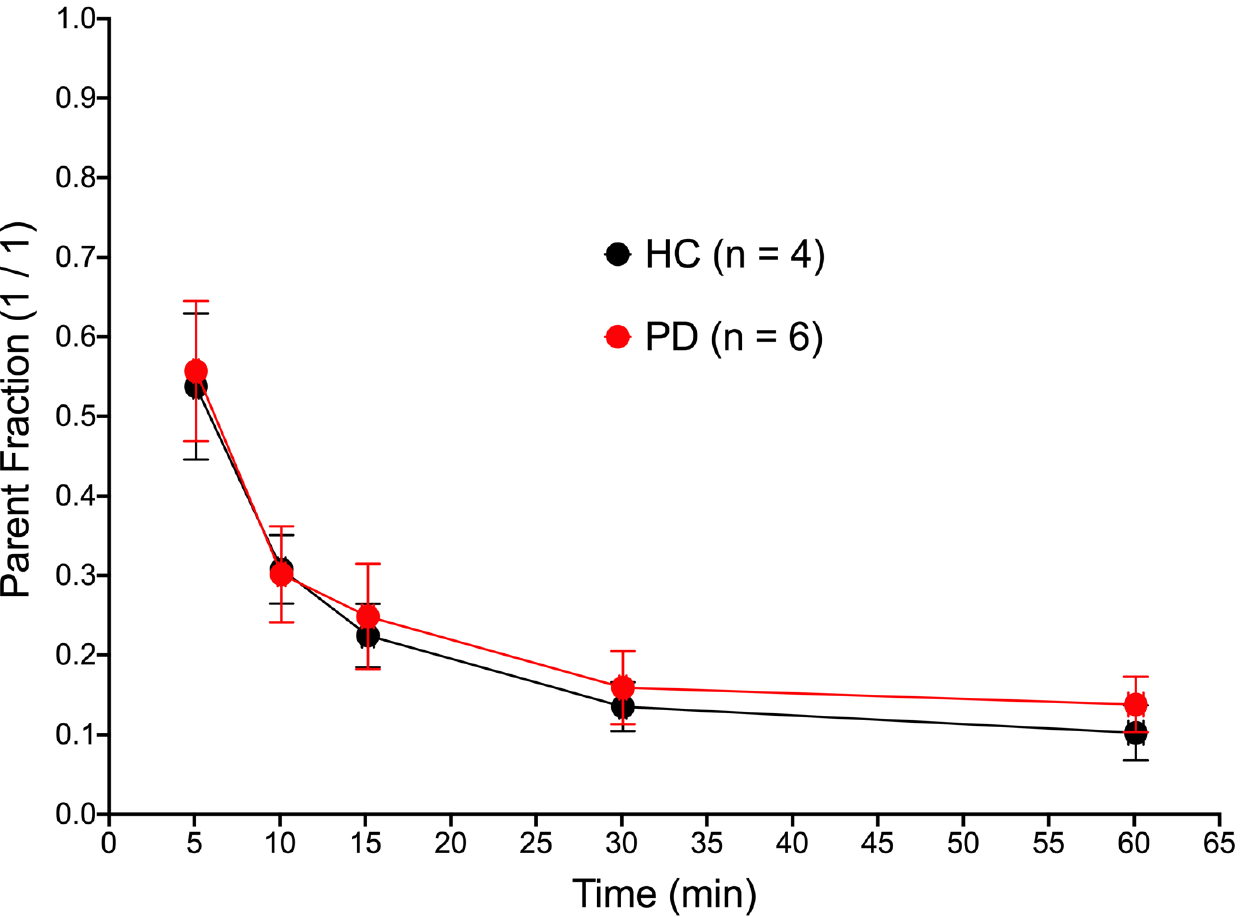
Figure 3. [ 18 F]NOS parent fractions in plasma, corrected for plasma protein binding, plotted as mean ± standard deviation.